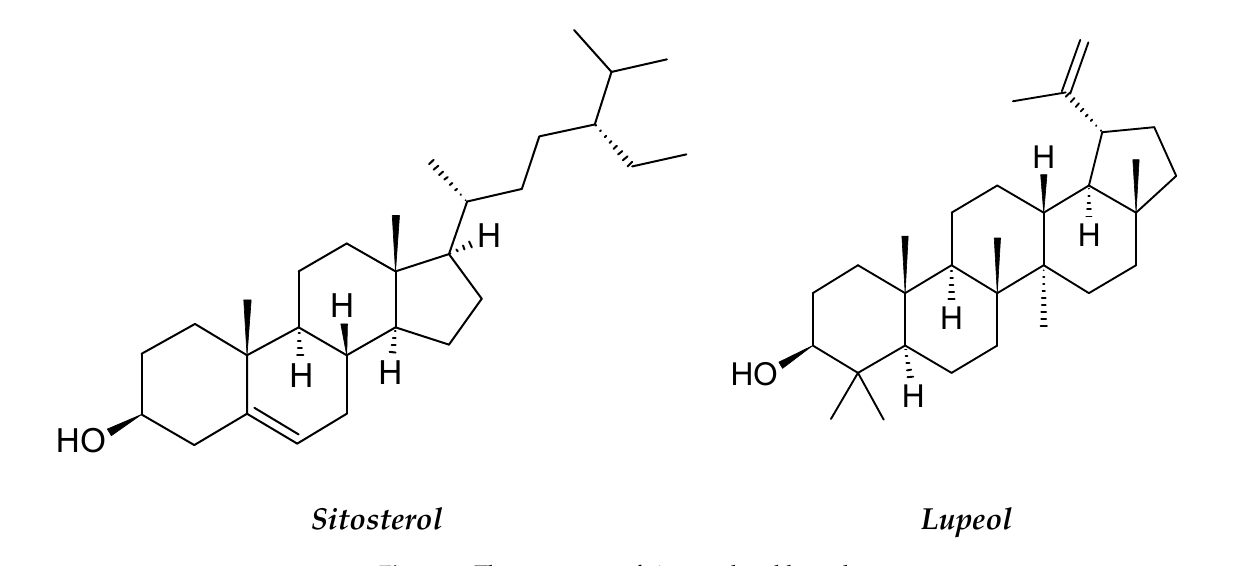
Figure 8. The structures of sitosterol and lupeol.